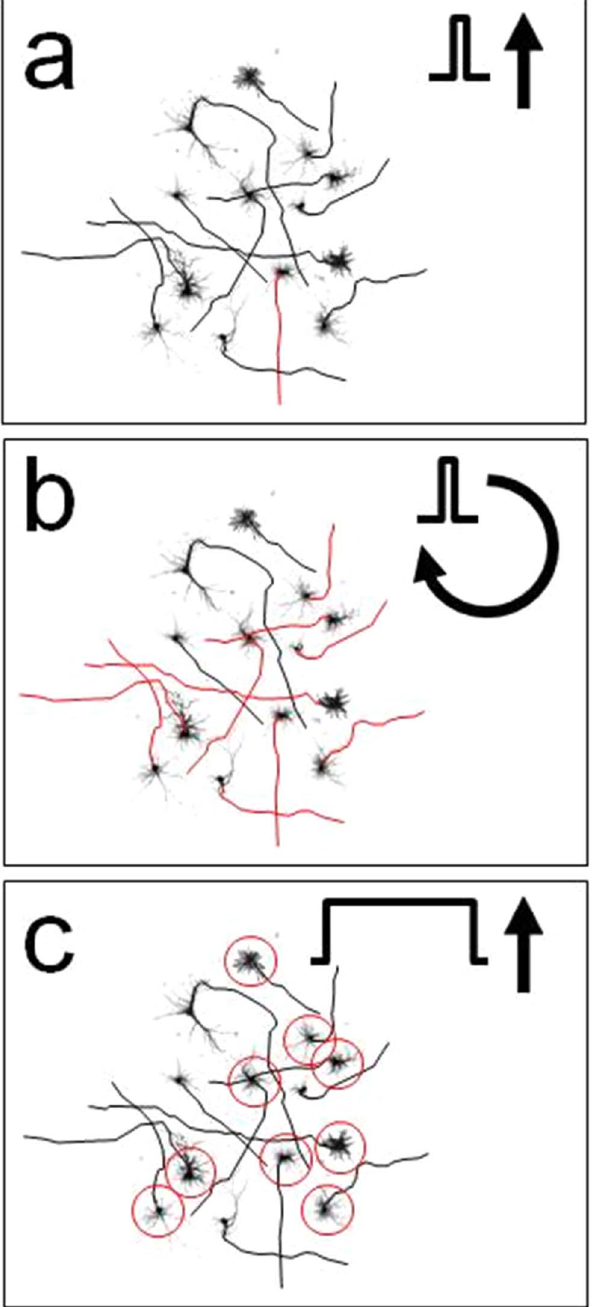
Figure 1. Schematic of a culture whose cell’s axons (red or black lines) are randomly orientated. a) A short magnetic pulse with a fixed single orientation (black arrow indicates direction of the stimulating field) stimulates only one cell whose axon (red line) is oriented parallel to the direction of the induced electric field is excited. b) A short rotating magnetic pulse (arc indicates the span of rotation of the stimulating field) stimulates all cells whose axons’ orientations lie within the arc of the rotating electric field (red lines), leading to a population response of the network. c) Alternatively, when applying a long magnetic pulse with a fixed orientation, all cells with dendrites oriented parallel to the direction of the induced electric field (red circles) are excited, leading to a population response of the network. See also Note S1, S2 and S3 in File S1.